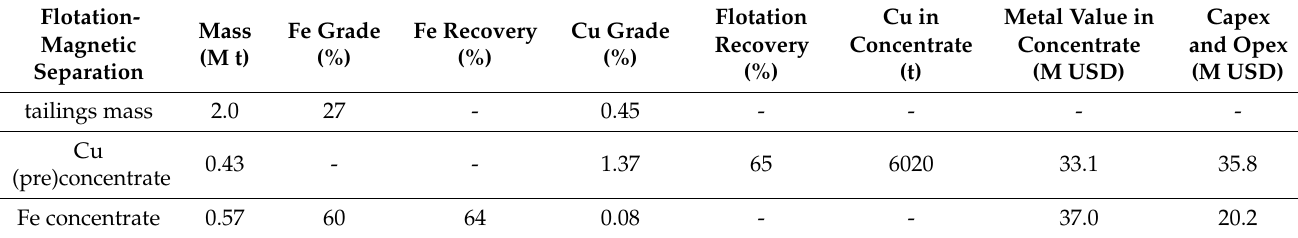
Table 9. Data of coarse-grained tailings material and (pre)concentrates of copper and iron, including recoveries, metal value and investment, processing, and transport costs for the scheme of first flotation and second magnetic separation. Flotation-